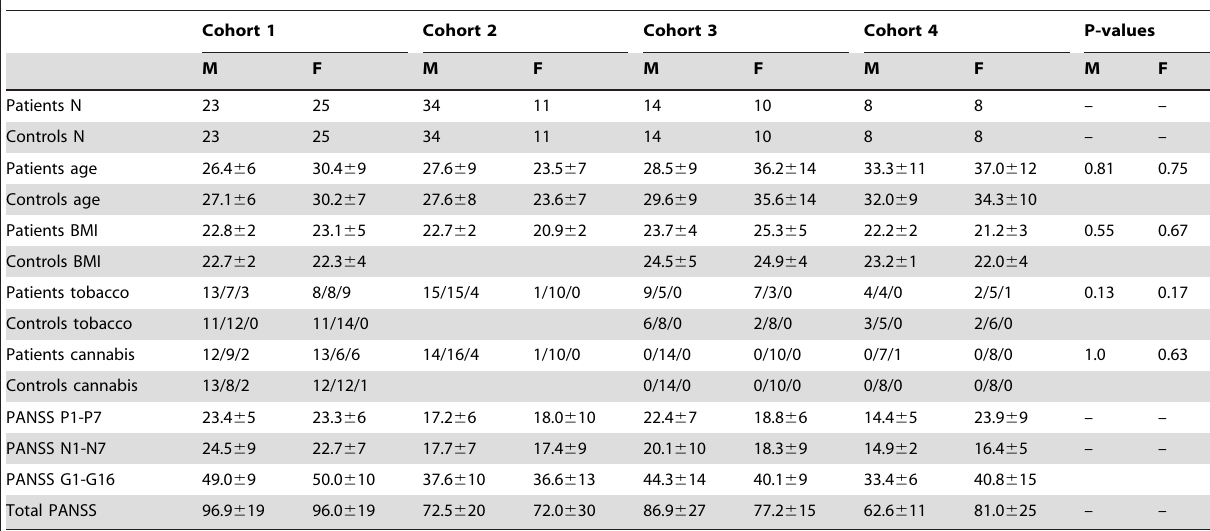
Values are shown as mean 6 sd. Tobacco and cannabis use is displayed as (yes/no/NA) and age is in years. M=male. F=female. N=number. BMI=body mass index (kg/ m 2 ). PANSS=Positive and Negative Syndrome Scale. The final two columns show that there are no significant differences in age, BMI, smoking, or cannabis use between